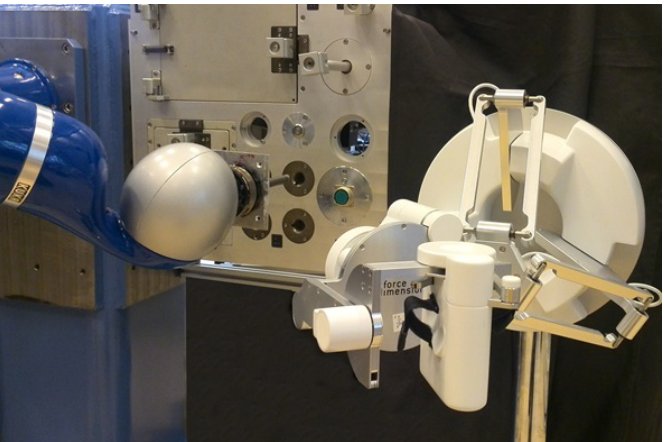
Figure 4. Overview of the Experimental setup used for learning from demonstration (LfD)-based haptic guidance, with the master device (Sigma.7 haptic master) and the KUKA lightweight slave robot manipulating a metal peg into a task-board receptacle.